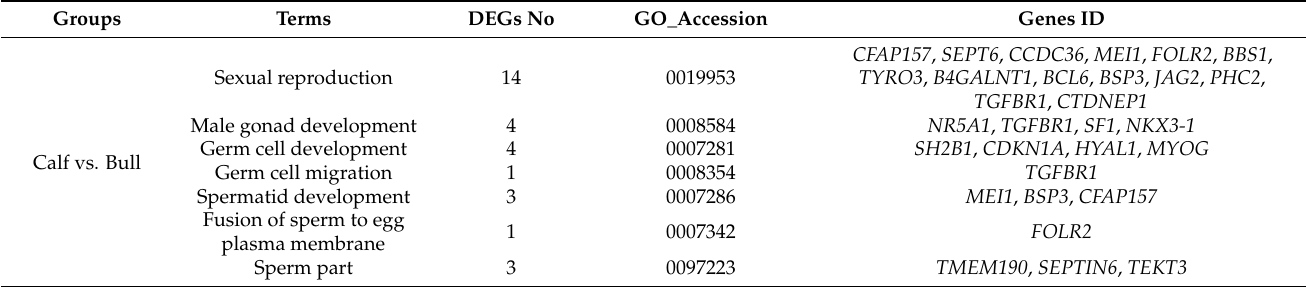
Table 3. Enriched GO terms and DEGs correlated with bull reproduction were